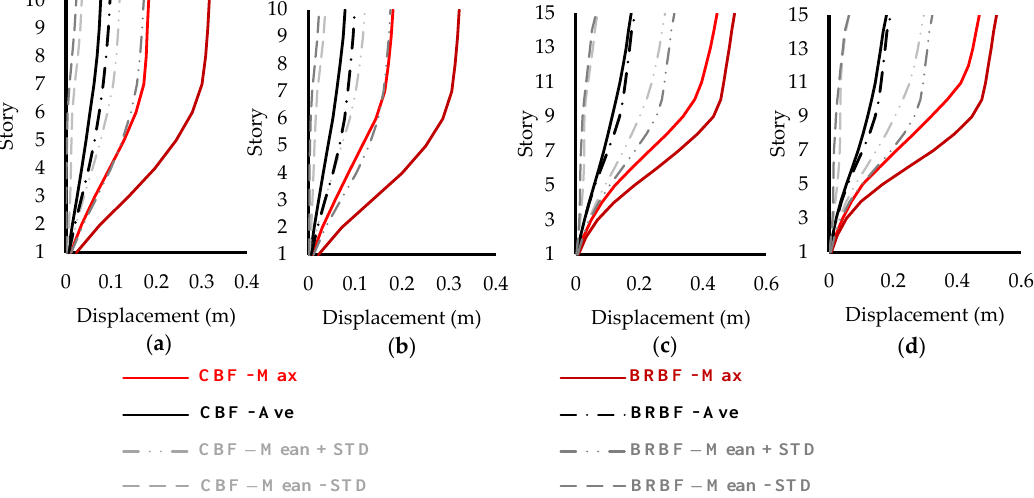
Figure 7. Displacement of ( a ) 10-story regular frames, ( b ) 10-story mass irregularity frames, ( c ) 15-story regular frames and ( d ) 15-story mass irregularity frames.